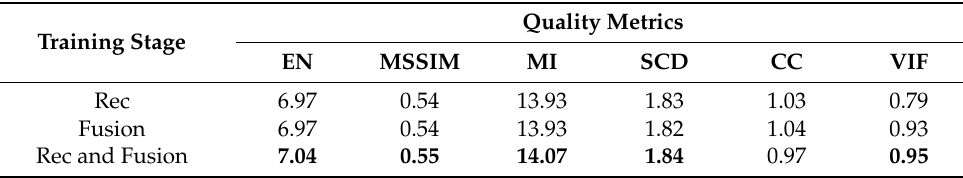
Table 1. Ablation study on the effectiveness of the multi-stage training approach compared with existing single phases. Bold represents for the best result in comparison.